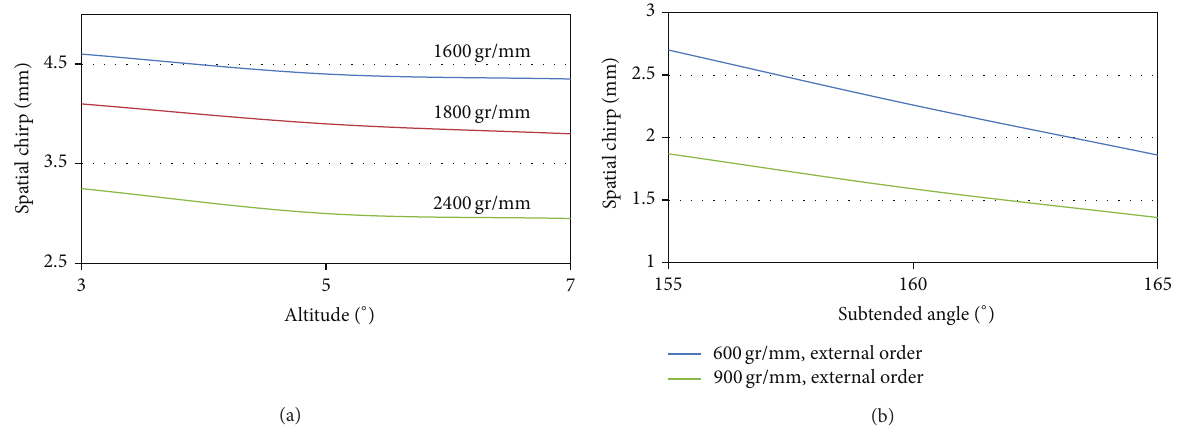
Figure 4: Spatial chirp of the FEL grating compressor: (a) OPM; (b) CDM.